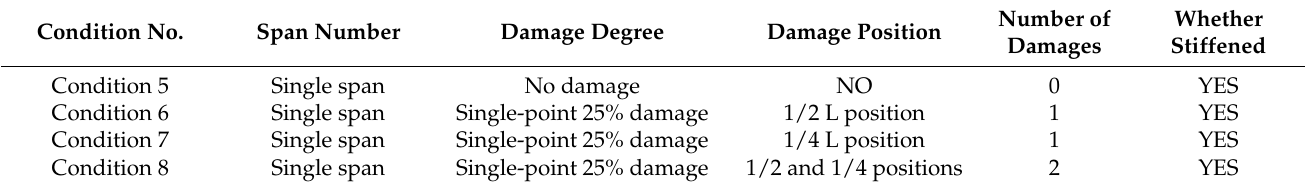
Table 2. Summary of stiffened condition.